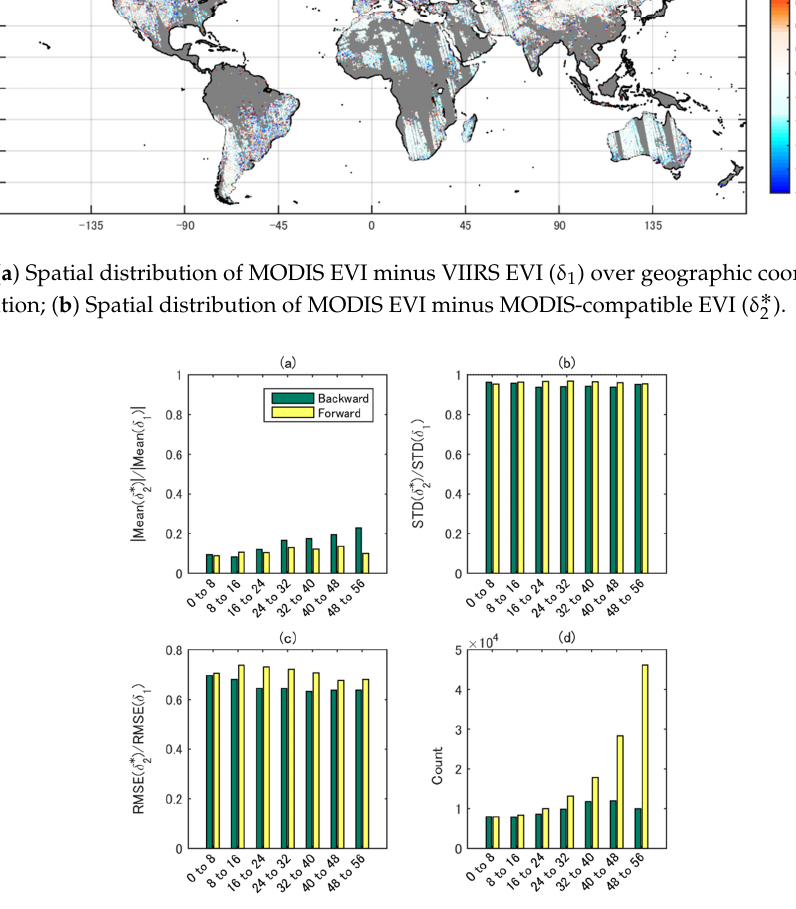
Figure 7. ( a ) Ratio of absolute mean of difference between MODIS EVI minus MODIS-compatible VIIRS EVI ( δ ˚ ) to that between MODIS EVI minus VIIRS EVI ( δ 1 ) for angular-dependent data (characterized 2 by backward or forward scatterings and view zenith angle); ( b ) Ratio of STD for δ ˚ to that for δ 1 ; 2 ( c ) Ratio of RMSE for δ ˚ to that for δ 1 ; ( d ) Frequency of angular distribution in data for 2 12/17